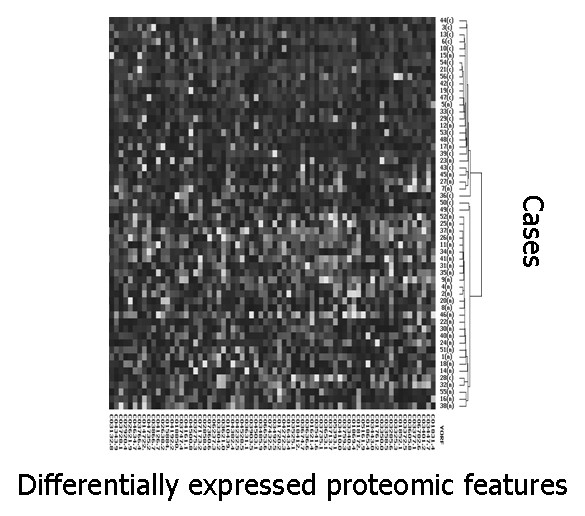
Expression difference map of gastric fluid and pellet extract proteins of training set samples on four ProteinChip arrays, displayed in two-way hierarchical clustering. Significant proteomic features are displayed vertically. The intensity of the grayscale indicates the degree of relative protein level, higher or lower than the median value. Patient cases are presented horizontally; most gastric cancer patients are tightly clustered together. This figure shows the upper quartile of the full image (please see Additional file 2 for the full image).